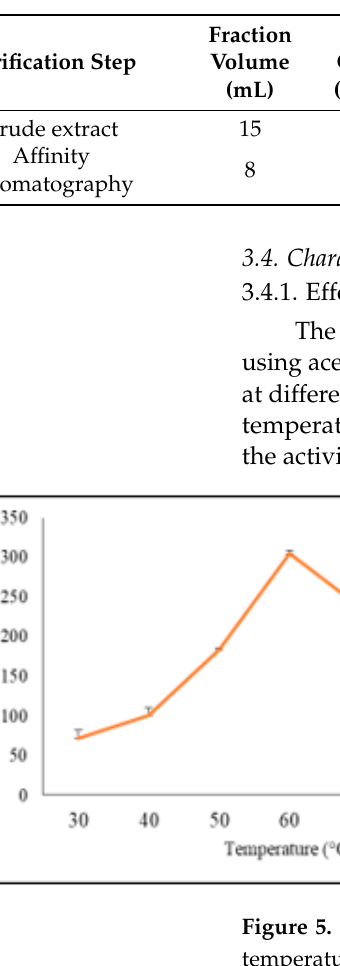
Table 2. Purification table of purified A. geothemalis ALDH using nickel sepharose affinity chromatography.